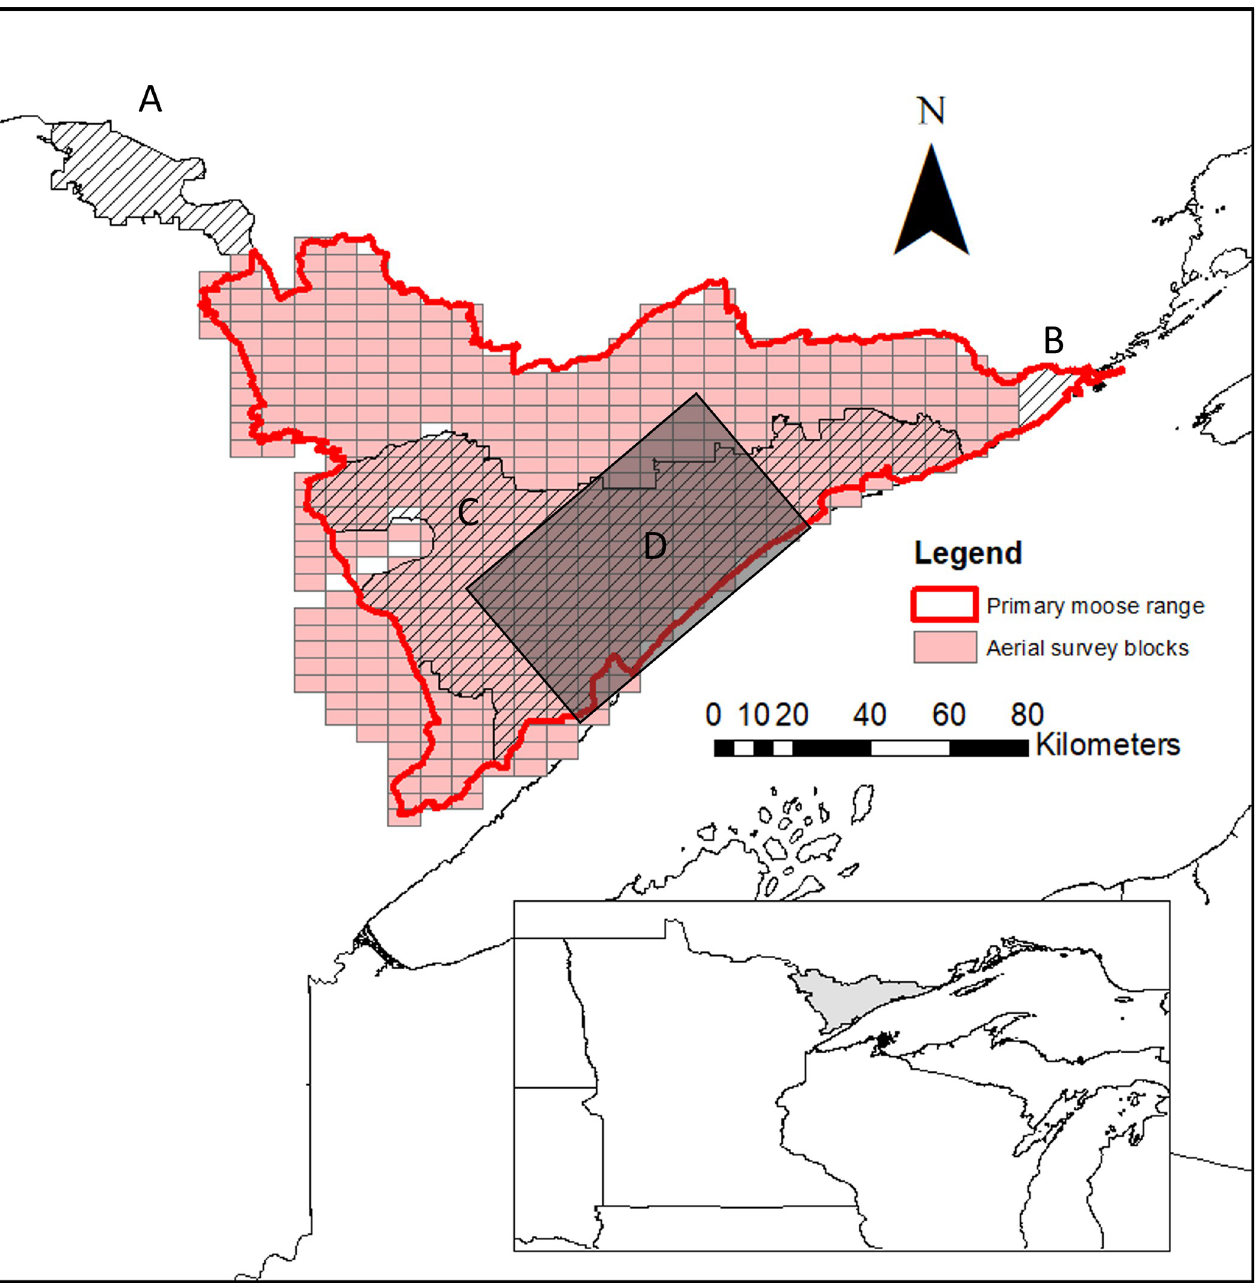
Fig 1. Study area map. Primary moose range in Minnesota (red outline) that is surveyed annually by cooperators Minnesota Department of Natural Resources (MNDNR), Fond du Lac Band of Lake Superior Chippewa (FDL), and 1854 Treaty Authority; and 4 study areas that contained collared moose: Voyageurs National Park (A), Grand Portage Indian Reservation (B), MNDNR study (2012–2016; C), and MNDNR-FDL-1854 Treaty Authority study (2005–2008;